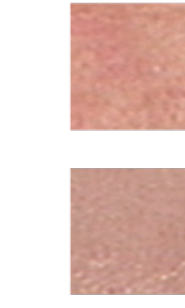
Figure 13. Three examples of LCB from BD and H, which cannot be distinguished with our naked